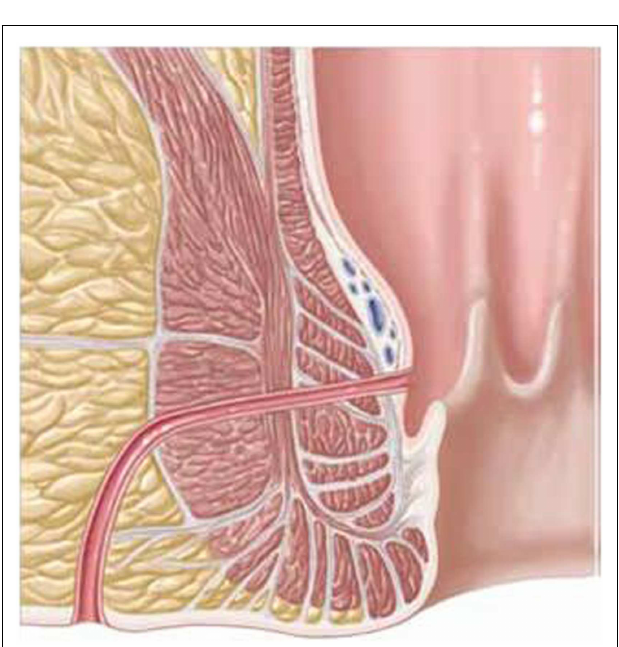
FIGURE 2 | Schematic drawing of a transsphincteric anal fistula